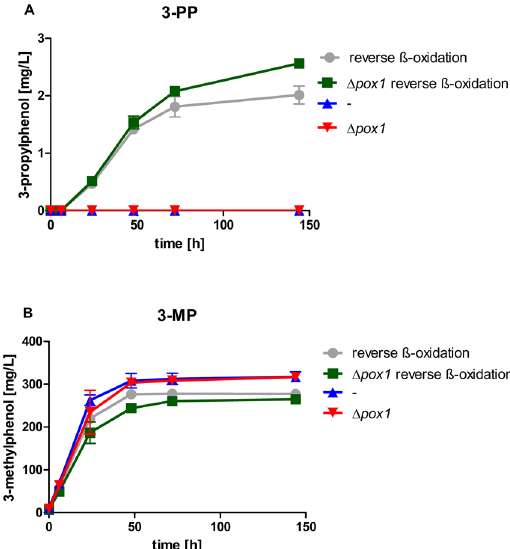
Figure 4. 3-Propylphenol formation via ‘reverse ß-oxidation’. 3-Propylphenol ( A ) and 3-methylphenol production ( B ) was measured in culture supernatants of CEN.PK2-1C expressing the 3-methylphenol pathway ( Ppopt MSAS , opt npgA and opt patG 14 ) with or without additional expression of the ‘reverse ß-oxidation’ pathway ( ERG10 , opt hbd , opt crt and opt ter 21,22 ) (strains 194 and 162, respectively), and with additional pox1 deletion (strains JHY212 and JHY211, respectively). High-OD fermentations (starting OD = 5) were performed in biological duplicates at 30 °C in KP i buffered YPD medium at pH 6.5. Culture supernatants were analysed via HPLC for 3-alkylphenol production. Error bars represent standard